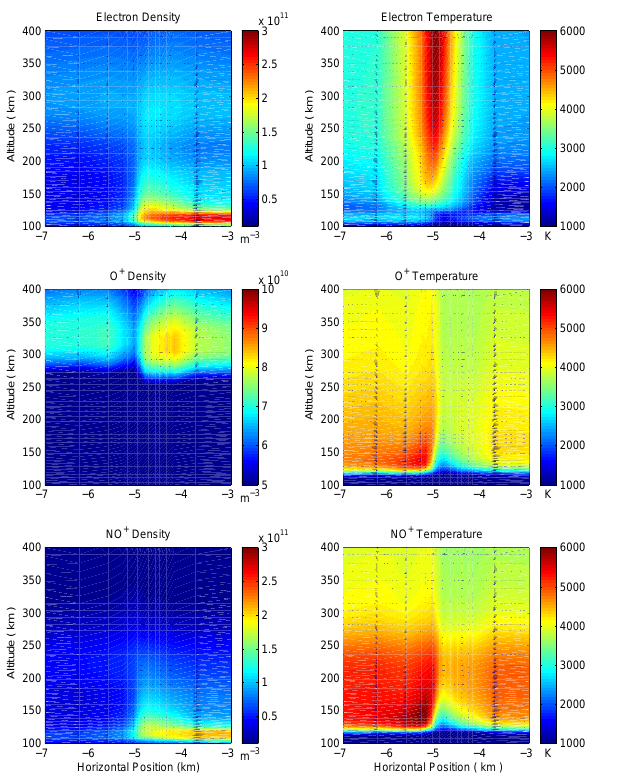
Fig. 8. Same as in Fig. 4, but with the addition of E -region wave heating of electrons, following the prescription proposed by Robin- son